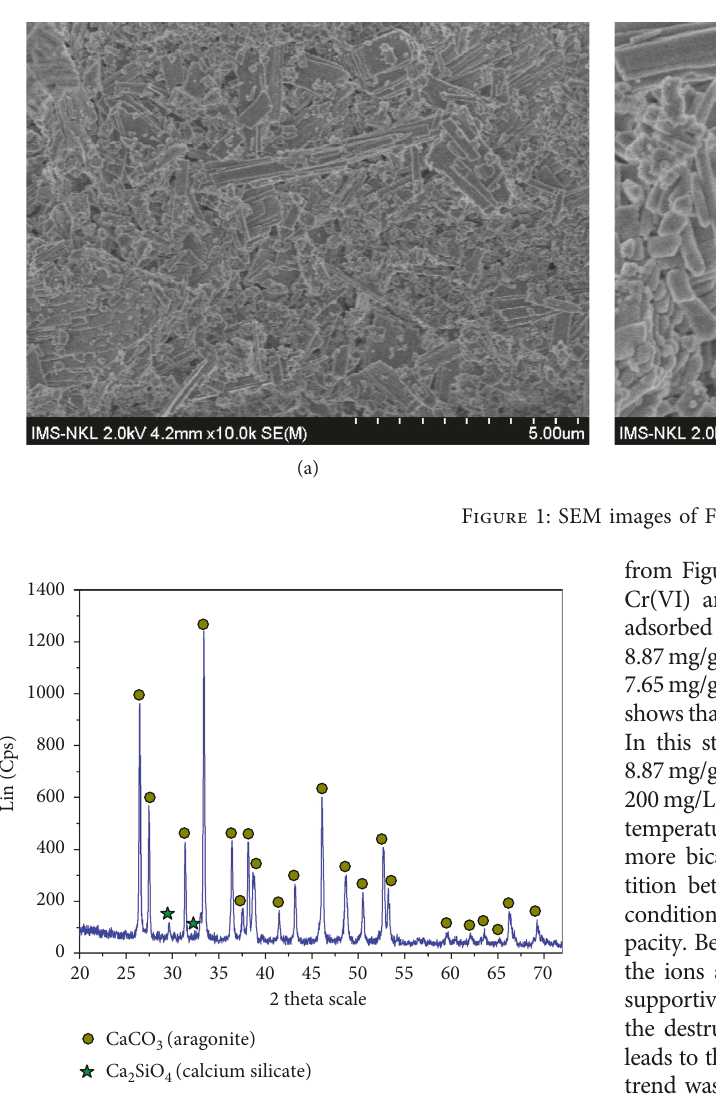
Figure 2: XRD pattern of